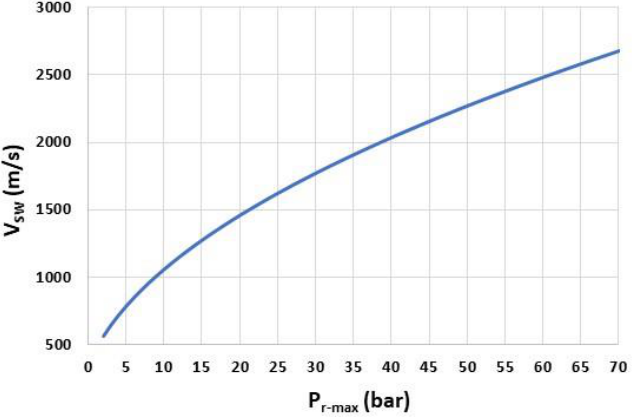
Figure 6. Shock-wave velocity 𝑉 𝑆𝑊 as a function of the overpressure peak 𝑃 𝑟−𝑚𝑎𝑥 .